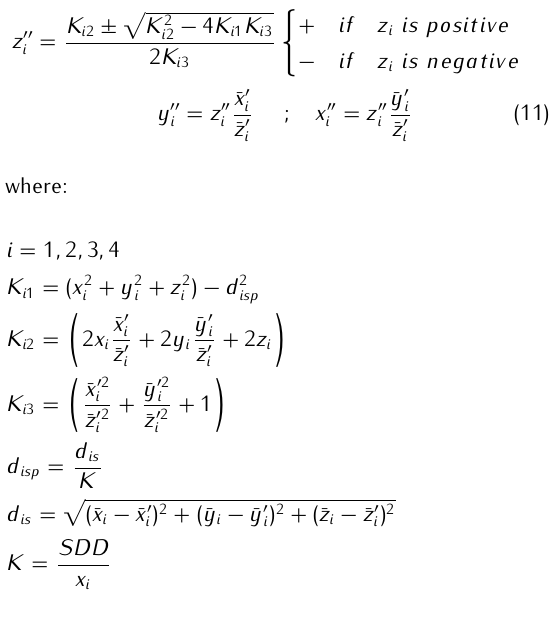
Figure 14. Relative Distances between Markers (Left-before motion, Right-after motion).